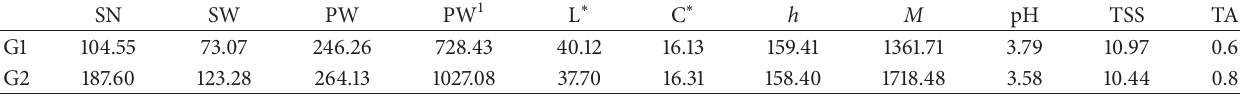
Table 1: Average values for morphological and chemical variables for two selections of soursop in Tepic, Nayarit